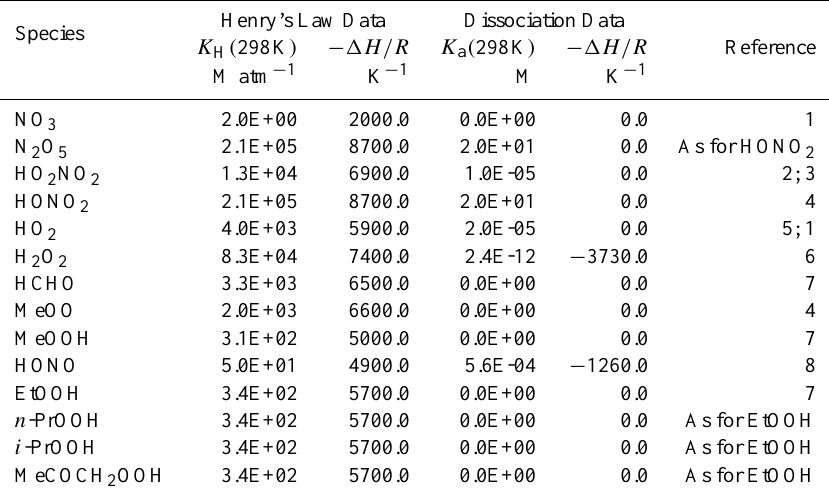
Table 1. Values required to calculate the effective Henry’s Law coefficient for the soluble species included in the UKCA standard tropospheric (StdTrop) scheme, where Me = CH 3 , Et = C 2 H 5 , and Pr = C 3 H 7 . References: (1) Jacob (2000); (2) Regimbal and Mozurkewich (1997); (3) CRC (2003); (4) Lelieveld and Crutzen (1991); (5) Hanson et al. (1992); (6) O’Sullivan et al. (1996); (7) Staudinger and Roberts (2001); and (8) Becker et al. (1996).